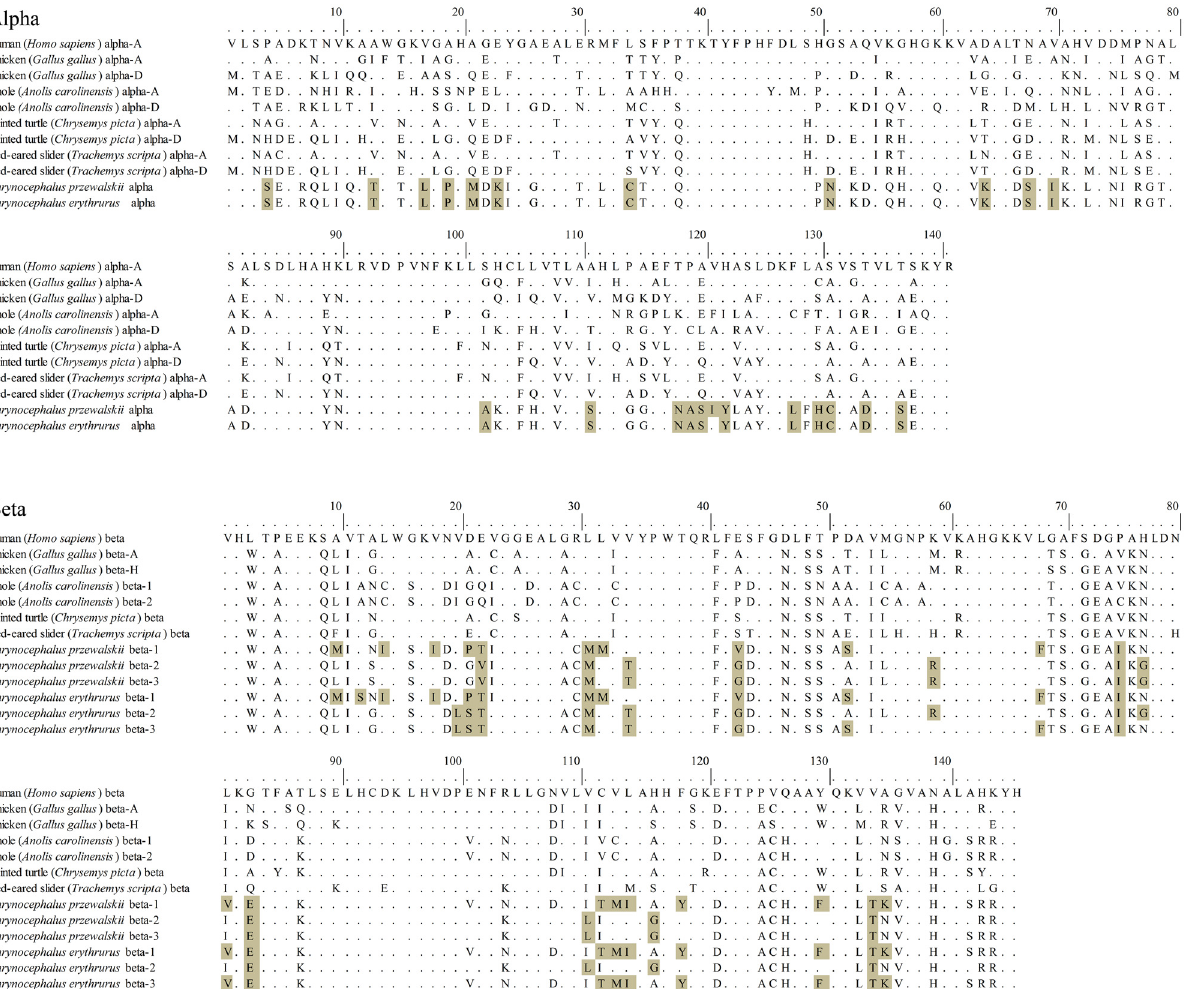
Fig 3. Alignment amino acid sequence of α - and β -like globin chains from the two lizard species and five outgroup taxa: human ( Homo sapiens ), chicken ( Gallus gallus ), anole lizard ( Anolis carolinensis ), red-eared slider ( Trachemys scripta ) and painted turtle ( Chrysemys picta ). The α - and β - globin polypeptides of both species were deduced from translated DNA sequences, peculiar amino acid of the two species were marked with light gray